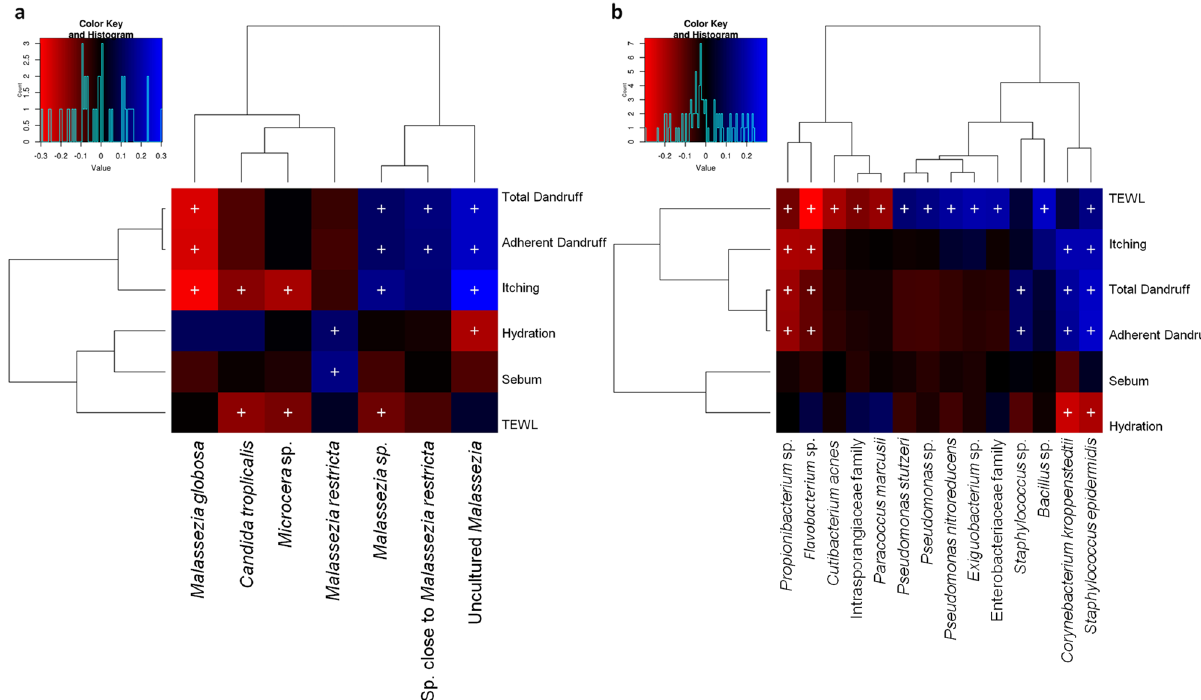
Figure 4. Spearman’s correlation between microbial taxa and host physiological parameters. ( a ) Fungal and ( b ) bacterial taxa showing significant correlations (+ , FDR adjusted p ≤ 0.05) with any of the parameters are plotted as a